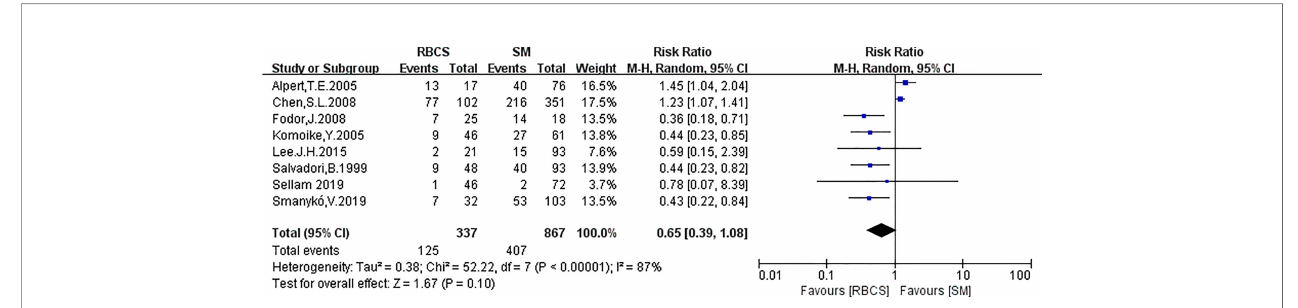
FIGURE 8 | Forest plot of repeated breast-conserving surgery (RBCS) versus salvage mastectomy (SM) after ipsilateral breast tumor recurrence (IBTR), comparing overall survival (OS). The meta-analyse was performed with random effects model. RR more than 1 means the results favor SM group.